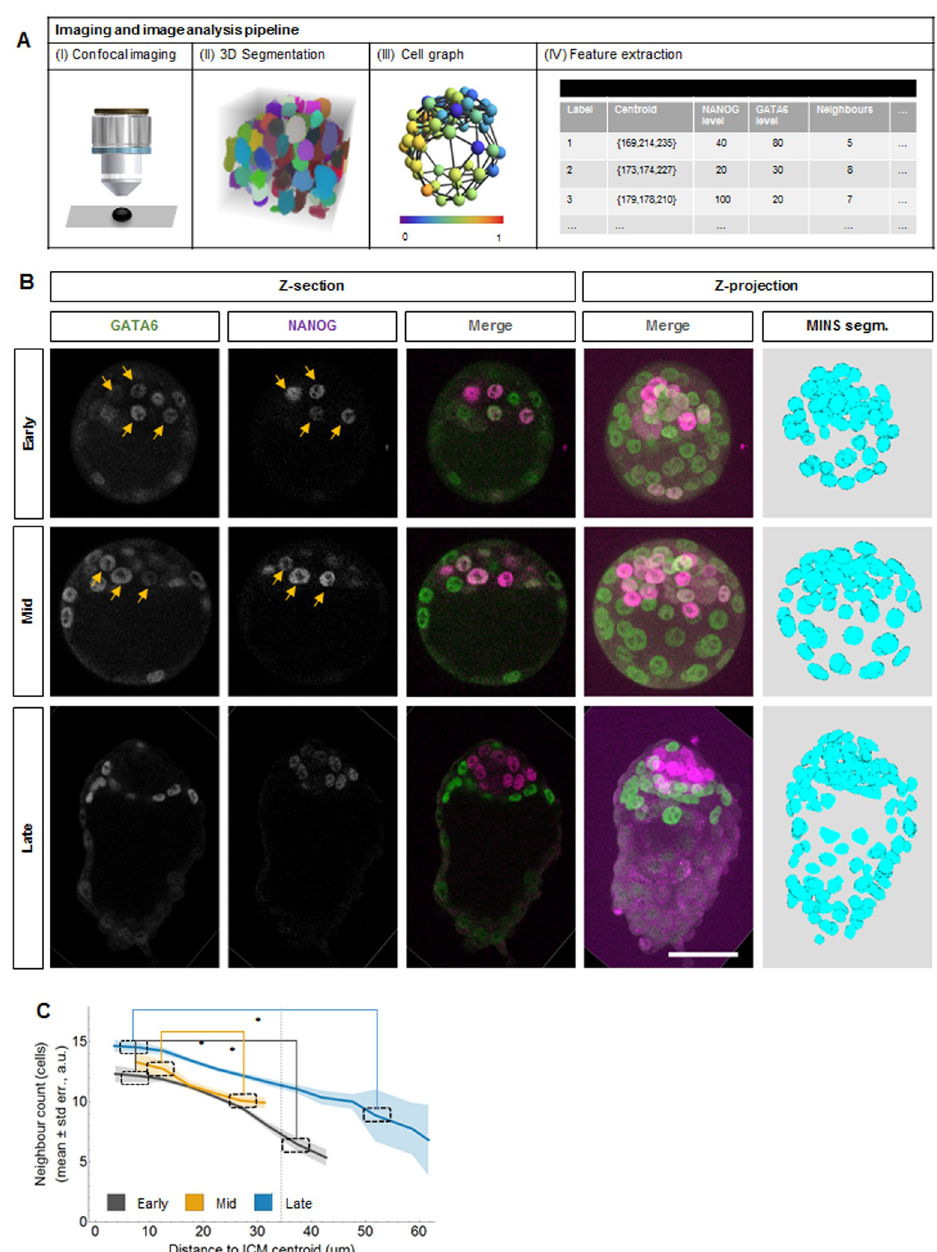
Fig 1. Three-dimensional imaging-based quantitative cell neighbourhood analysis of Epiblast vs Primitive Endoderm fate differentiation in preimplantation mouse embryos (data I). (A) Image analysis pipeline for quantitative characterization of mouse embryos. (I) Imaging with confocal laser scanning fluorescence microscope using sequential scan mode. (II) Segmentation with MINS. (III) A graphical representation of the Delaunay Cell Graph. (IV) Feature extraction for individual cells. See also S1 Fig. (B) Representative confocal images of mouse preimplantation embryos immunostained for GATA6 (green) and NANOG (magenta) at the indicated developmental stages. Yellow arrows point to cells co-expressing NANOG and GATA6. All embryos shown were immunostained, imaged and processed together. The first three columns are single confocal z-sections, the last columns show the maximum z-projection of the merged confocal and the segmented images. Scale bar: 50 μ m. (C) Mean number of neighbouring cells (vertical axis) versus the distance to the centre of the ICM (horizontal axis) in early (grey), mid (yellow) and late (blue) embryos for data I. The shaded regions display the standard errors of the means. Mann- Whitney test with Bonferroni correction; � : p < 0.05. Details on the number of embryos and cells analysed are in S1 and S2